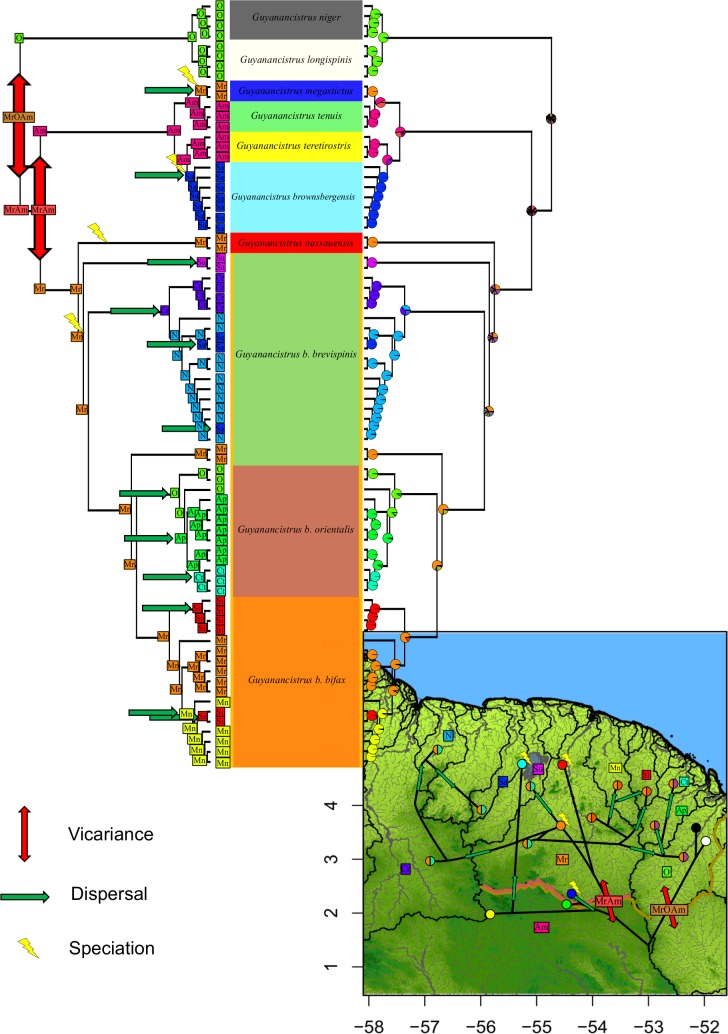
Biogeographical analysis of Guyanancistrus spp. using BioGeoBEARS under DEC + j model of ancestral area reconstruction.Eleven biogeographical areas corresponding to catchment areas were retained: Am: Upper reaches of Amazonian tributaries (including headwaters of Jari and Paru de Oeste rivers); Cr: Corantijn River; N: Nickerie River; Sa: Saramacca River; Su: Suriname River; Mr: Maroni River; Mn: Mana River; Si: Sinnamary River; Ct: Comté-Orapu River; Ap: Approuague River; O: Oyapock River. Pie charts at nodes indicate maximum likelihood of ancestral area reconstructions. Vertical double arrow indicates vicariant events (area fragmentation), horizontal simple arrow indicates dispersal events (gain of an area), and lightning identifies speciation events. A map provides interpretation of general displacements of species and populations within Eastern Guianas. Colored chips refer to species and subspecies following color scheme of Fig 4.